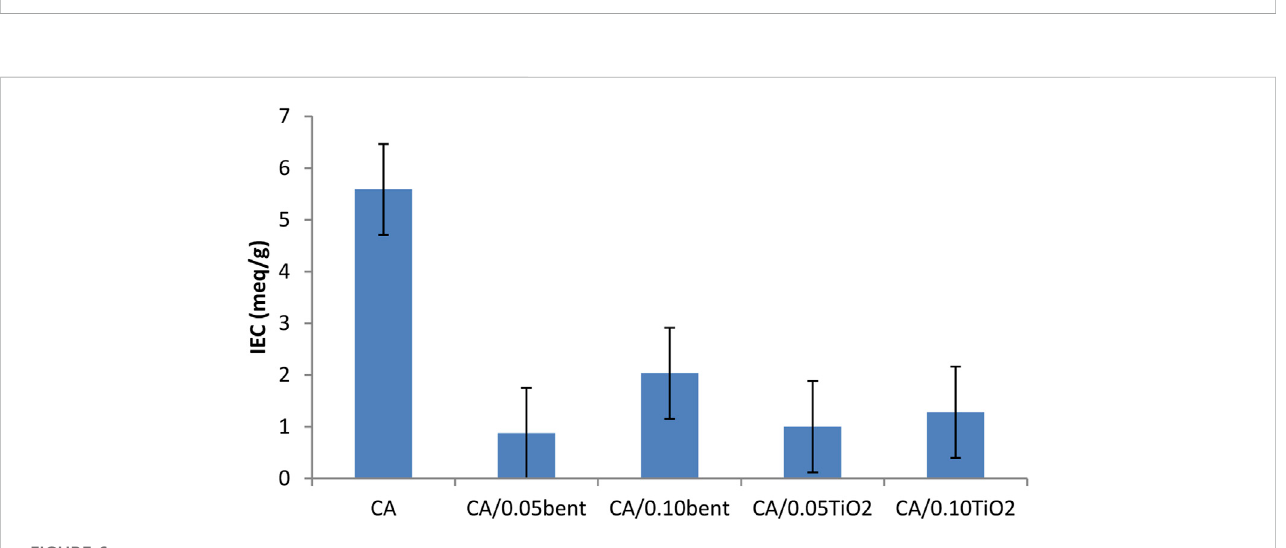
FIGURE 6 IEC of prepared cellulose acetate nanocomposite